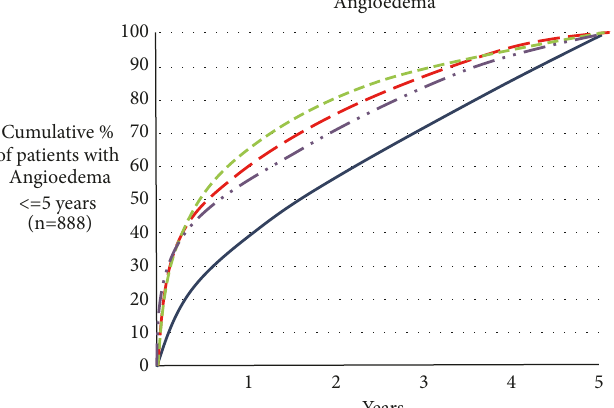
Figure 3: Cumulative percentages of developing angioedema and other side effects of ACEI with time (Banerji et al., 2017)